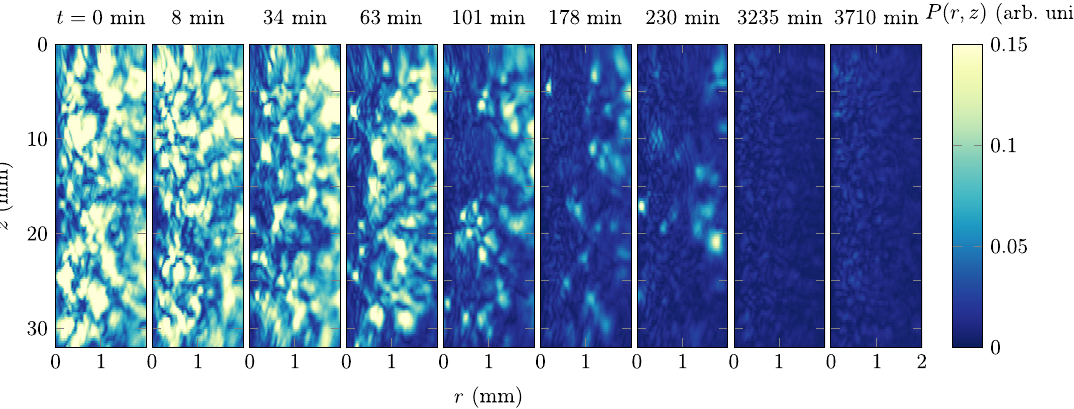
FIG. 9. Removing air bubbles trapped in the cornstarch dispersion. Maps of the amplitude P ð r; z Þ of the ultrasonic pressure signal backscattered by the cornstarch suspension at various times during preshear under a shear stress σ ¼ 5 Pa. The bright spots in the images correspond to air bubbles that are initially trapped but progressively rise through the sheared suspension until no bubble is seen across the ultrasound region of interest after about 5 h.